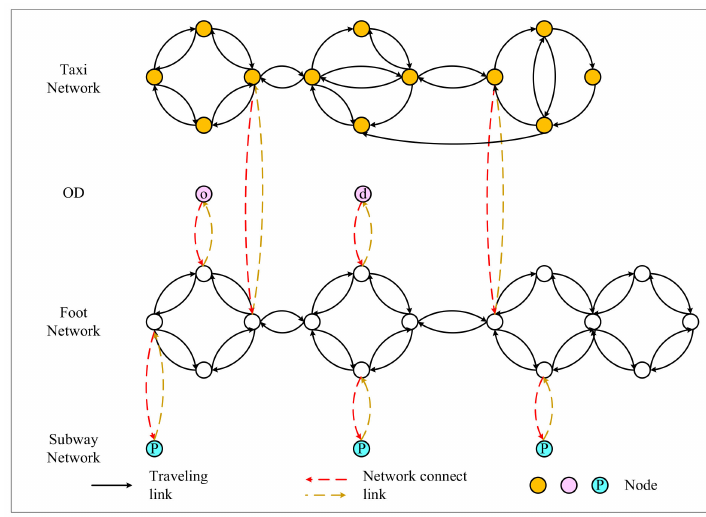
Figure 5. Transactions between subway and